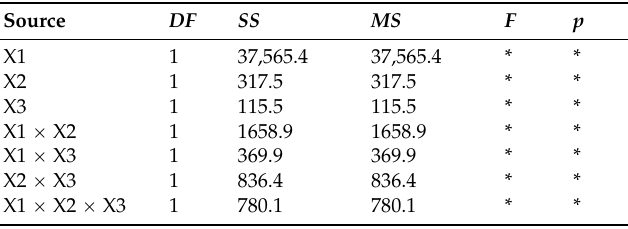
Table 9. ANOVA result including two-way and three-way interactions. DF : degree of freedom; SS : sum of squares; MS : mean square; F : F -ratio; p : p -value.